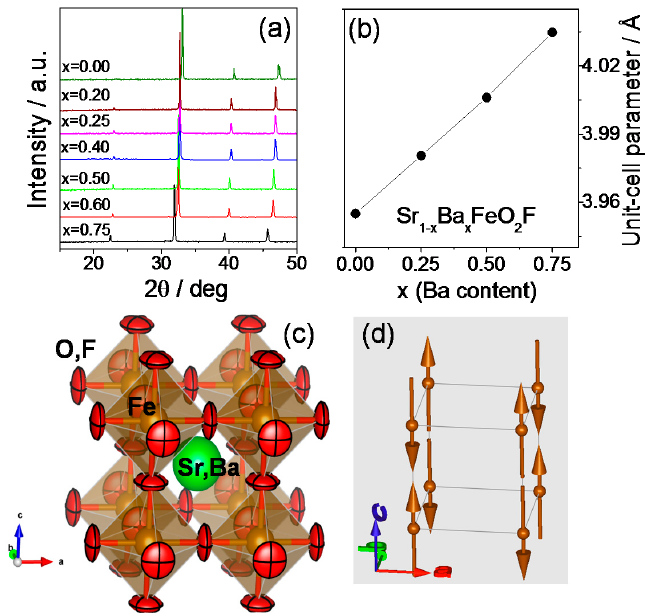
Figure 1. ( a ) X-ray diffraction (XRD) patterns (Cu K α ) for Sr 1 − x Ba x FeO 2 F ( x = 0.00, 0.25, 0.50, 0.75). They all may be indexed in cubic P m-3m symmetry; ( b ) unit cell parameter variation with the Ba content ( x ); ( c ) view of the cubic crystal structure, displaying the anisotropic ellipsoids of (O,F) atoms, drawn with a 95% probability; ( d ) G-type antiferromagnetic structure determined from Neutron Powder Diffraction (NPD) data.